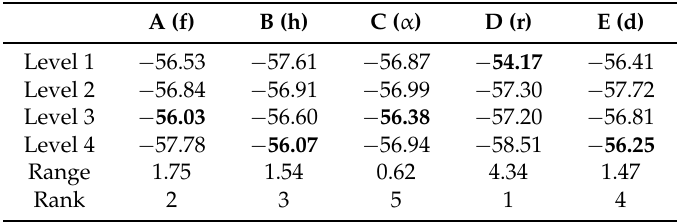
Table 4. Wear response of the third upper punch based on S / N W ratios.